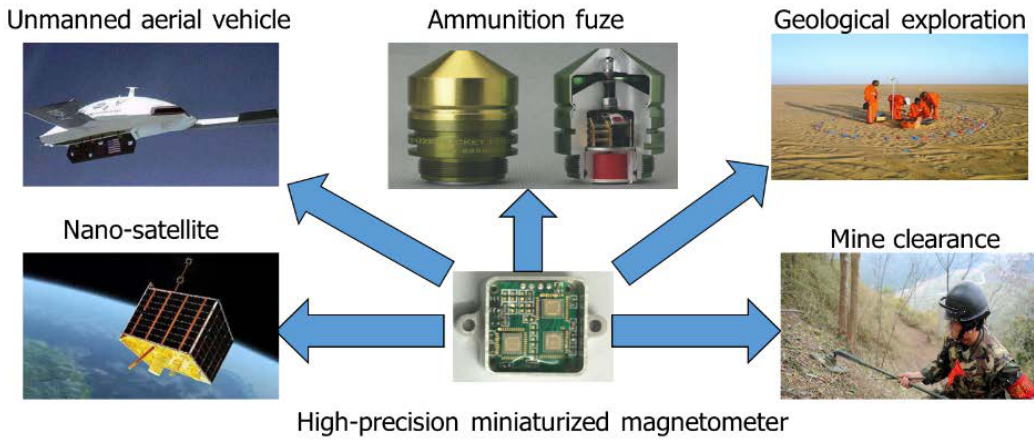
Figure 1. The high-precision miniaturized magnetometer in military and civilian field.